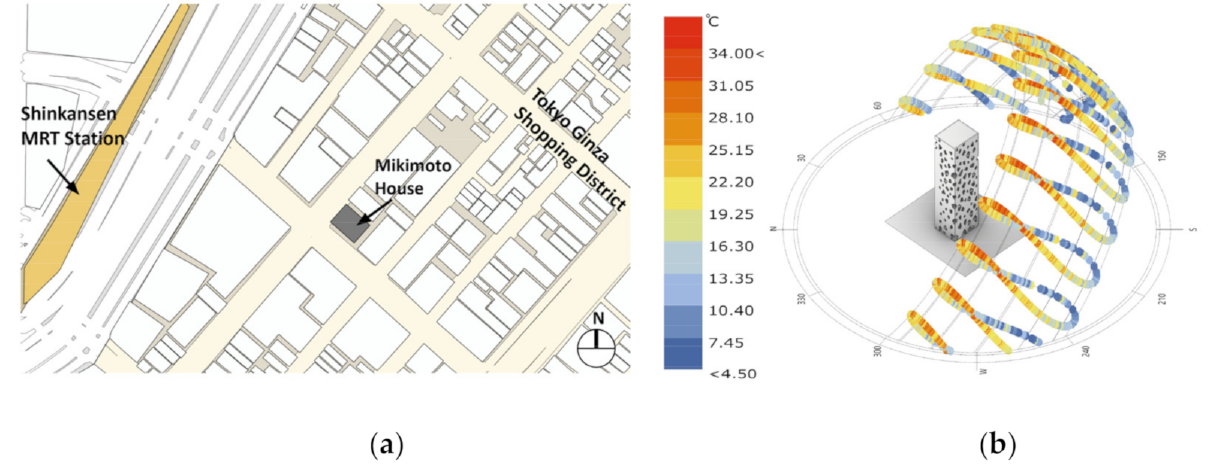
Figure 5. Mikimoto Ginza 2 location ( a ) and sun path visualization showing the relative dry bulb temperature ( b ).